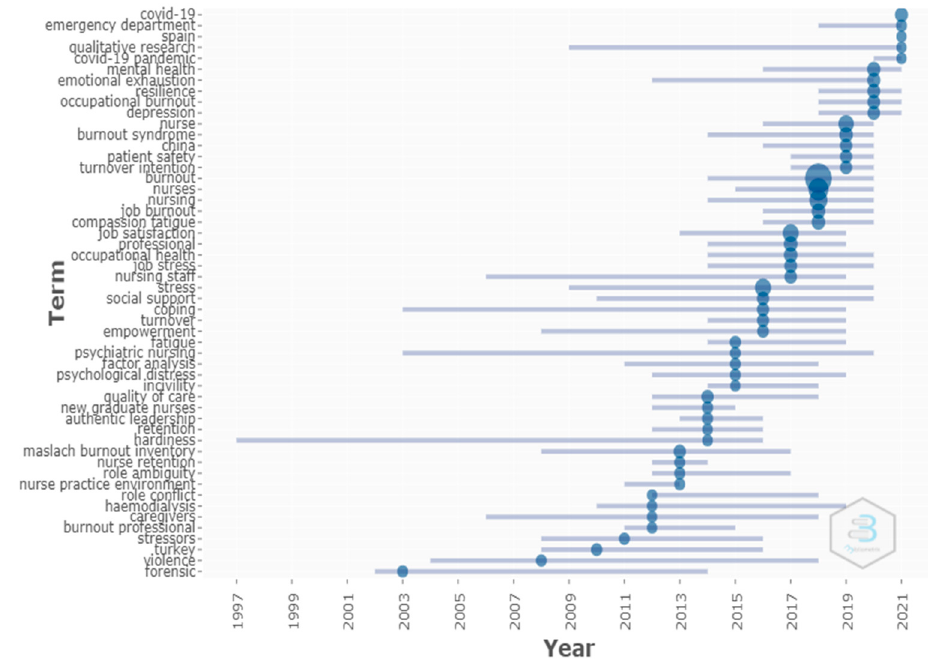
Figure 8. Trending